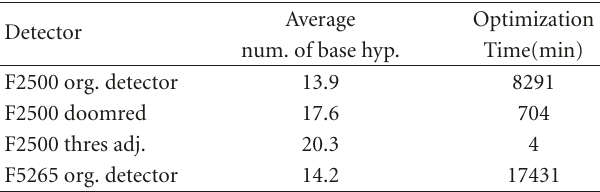
Table 2: The average number of the base hypotheses evaluated per each nonface instance and the optimization (or training) time estimated on Pentium 4 2.8 GHz